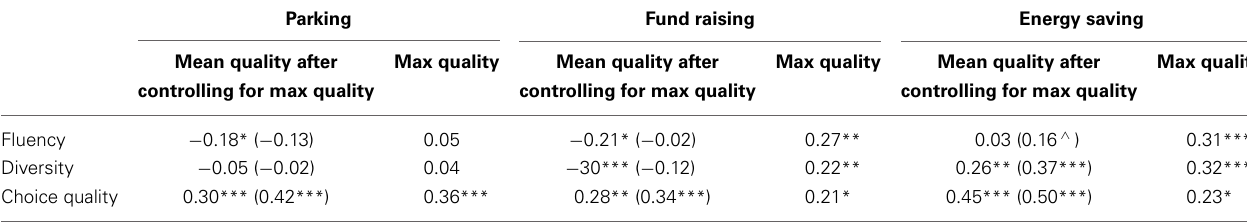
Table 3 | Pairwise bivariate correlations between measures of option